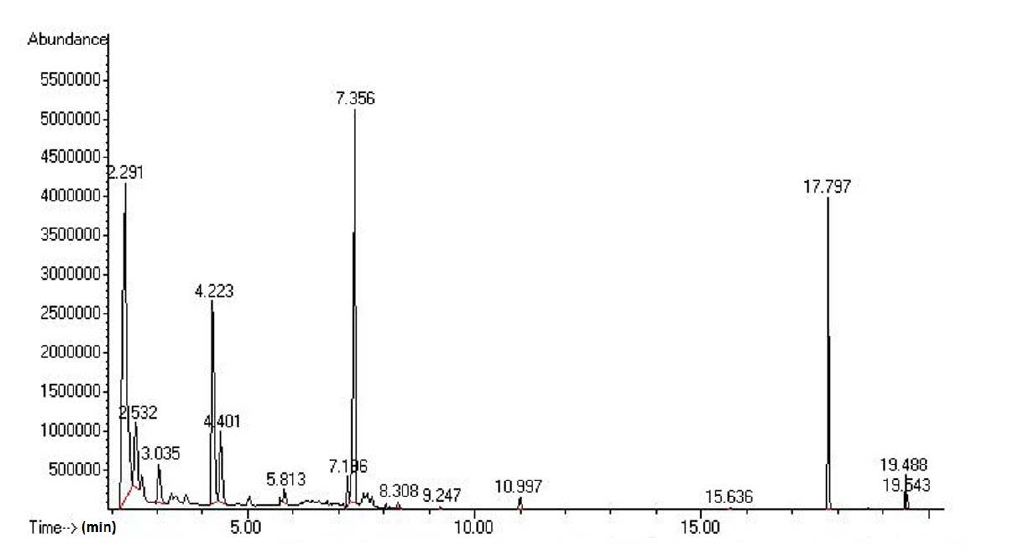
Figure 2. GC profile of volatile compounds extracted from the Budu 1 using an HP-5MS